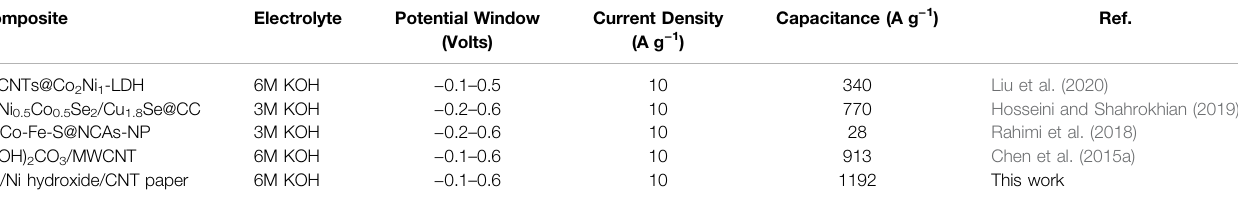
TABLE 1 | Summarized electrochemical performance data of related Co/Ni hydroxide/CNT paper based electrode materials for supercapacitors. Composite Electrolyte Potential Window